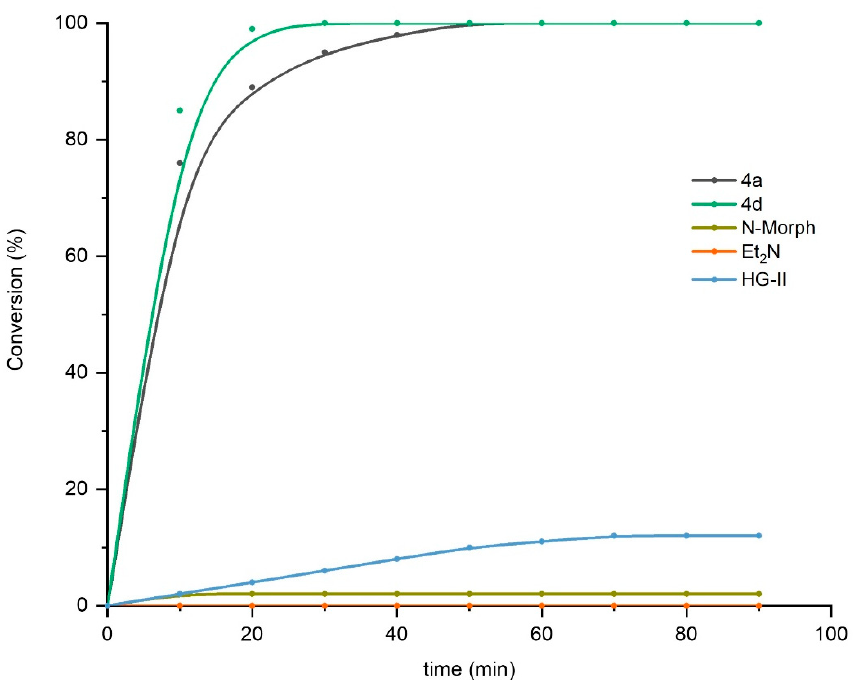
Figure 3. Time/conversion curves for RCM transformations of 7 (0.8 mmol, 200 mg) to 8 under the action of catalysts 4a , 4d compared with the previously reported ones for N-Morph [28], NEt 2 [29] (for structures, see Figure 1) and HG-II [44]. Conditions: catalyst loading is 0.1 mol% (0.0008 mmol), 25 ℃ , Ar, dry CH 2 Cl 2 (20 mL).